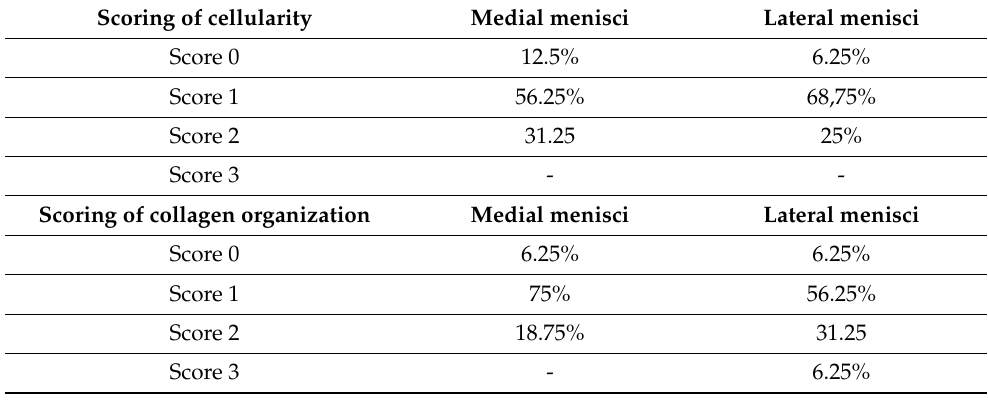
Figure 4. Total histological degeneration score in medial and lateral menisci. There was a signifi-